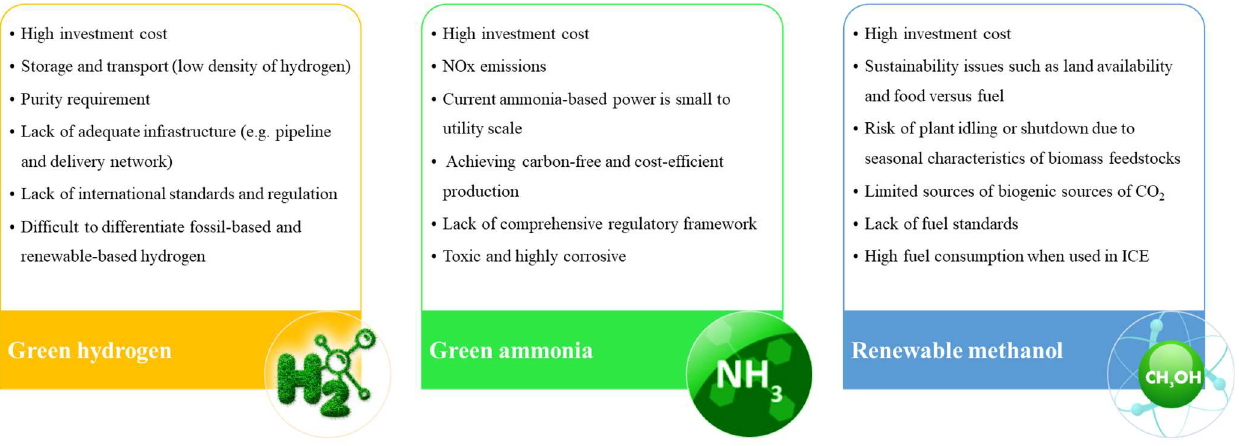
Figure 11. Critical challenges facing the development of carbon-neutral fuels.